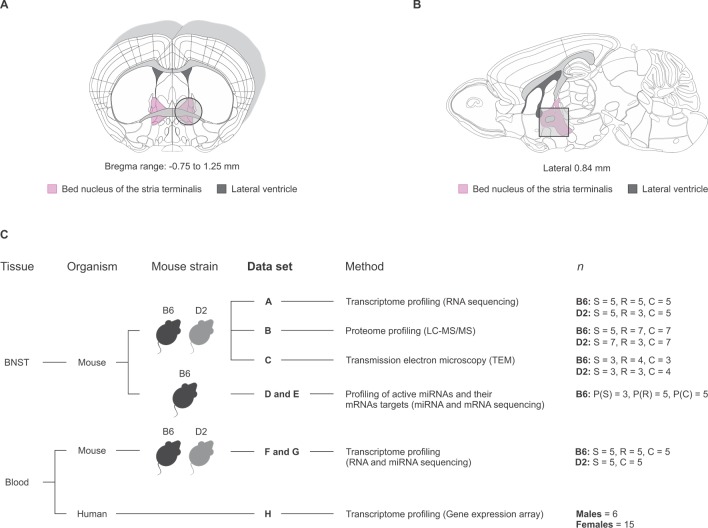
Overview of the BNST tissue collection and analyzed data sets.(A-B) BNST was dissected from both hemispheres by punching the indicated area (shaded area outlined with a circle or a square) for (A) transcriptomic, proteomic, profiling of active miRNA and their target mRNAs, and (B) transmission electron microscopy (TEM) analyses. Figure outlines are based on Allen Mouse Brain Atlas [103, 104]. The bregma for outline shown in figure (A) is 0.38. (C) Schematic of analyzed data sets. B6: C57BL/6NCrl; C: control; D2: DBA/2NCrl; LC-MS/MS: liquid chromatography–tandem mass spectrometry; R: resilient; S: susceptible.